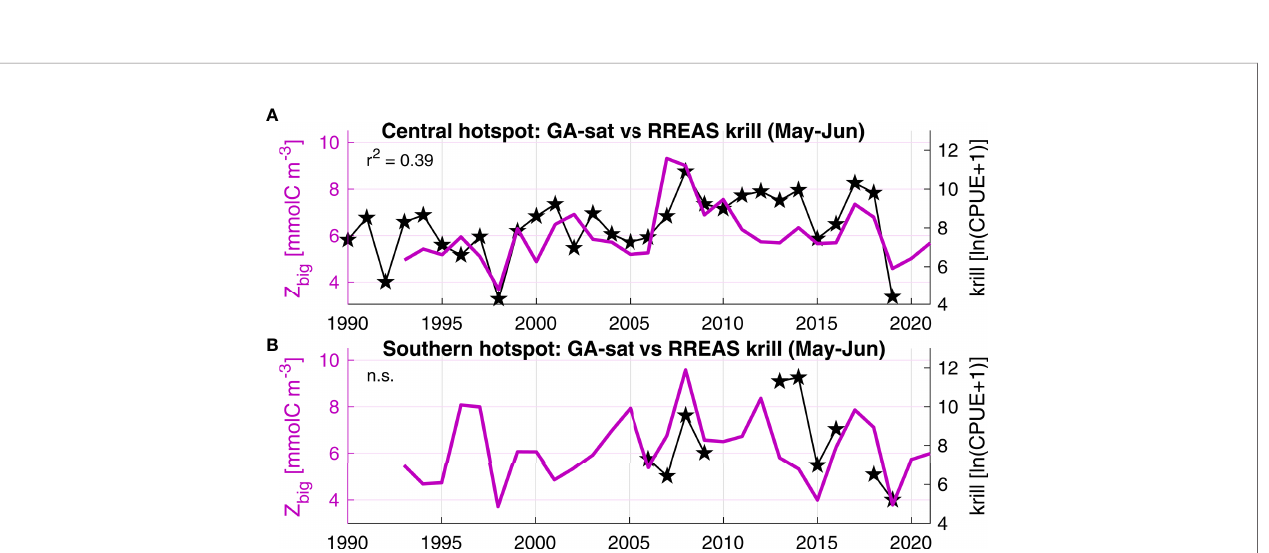
FIGURE 6 | GA-sat temporal variability (purple) evaluated with RREAS trawl krill survey (black). (A) The central hotspot overlaps with the RREAS core area continuously sampled since 1990. Both datasets were averaged during May-June, up to 150 km offshore for GA-sat Z big . (B) The RREAS also surveys the southern hotspot, although more recently and with less coverage (years with less than 10 trawl stations were excluded). In this region GA-sat Z big was averaged up to 100 km offshore (the southern hotspot is closer to shore than the central hotspot in GA-sat). The correlation between krill and Z big is non-signi fi cant (n. s.) for the southern hotspot, partly due to the low number of data